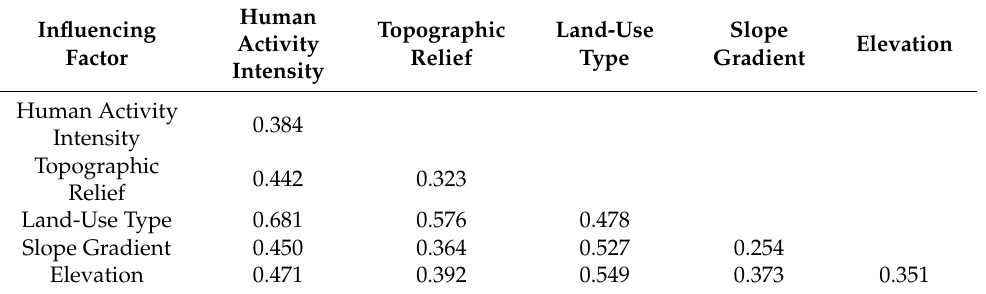
Table 5. Interactive detection